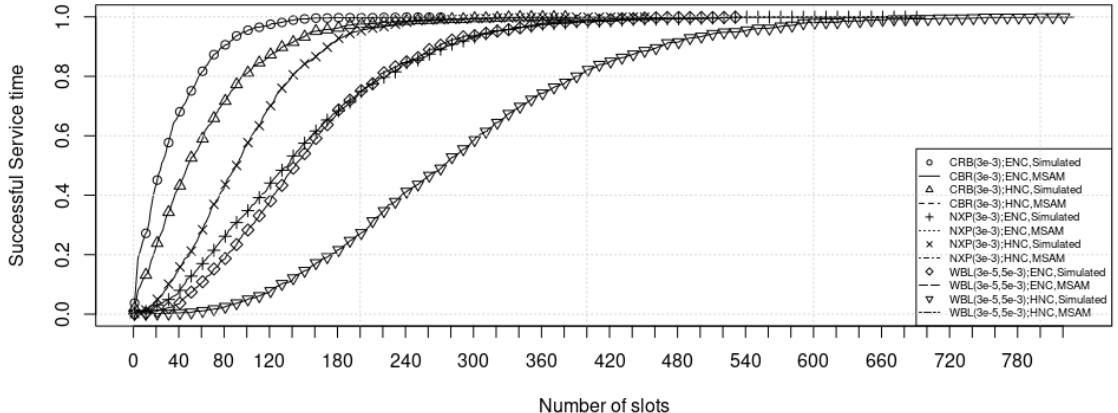
Figure 5. The Cumulative Distribution Functions of the successful service times.